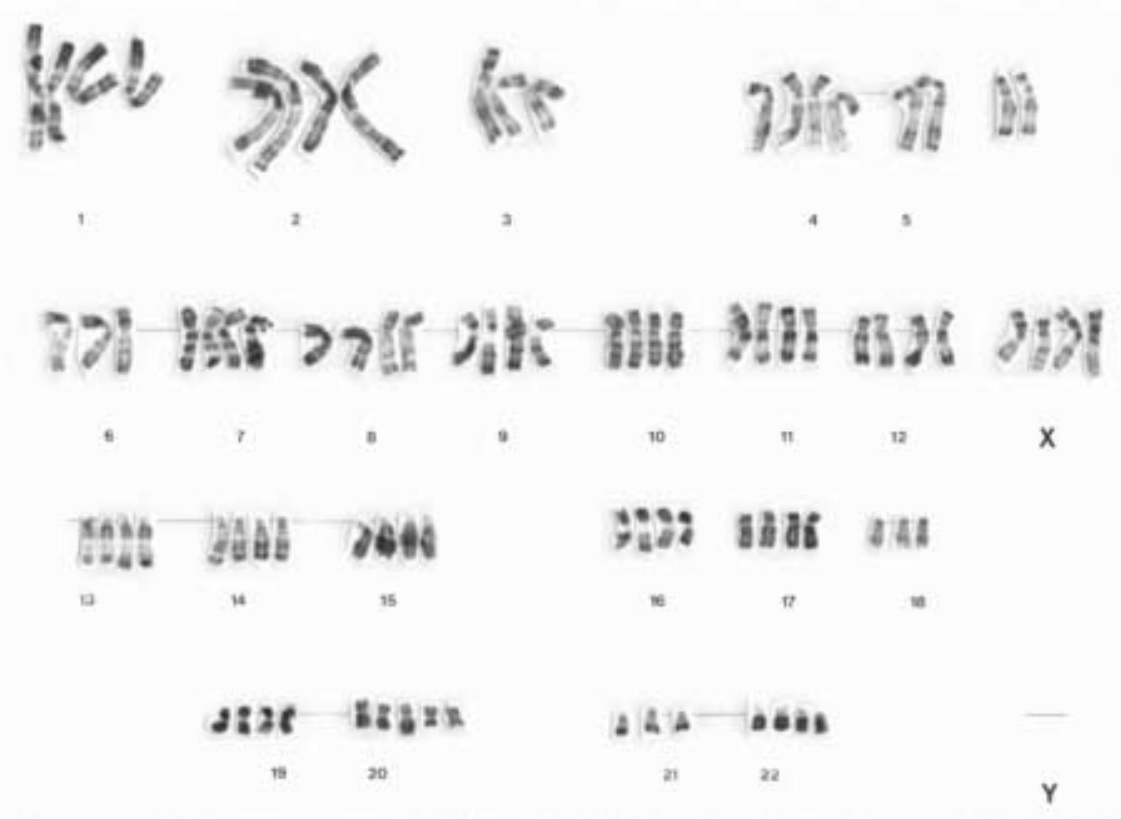
Fig. 1. R-banded karyotype of a representative near-tetraploid metaphase of Igrov1. The karyotype was interpreted as 85–92,XXX,der(X)t(X;18) (p11;p11),t(2;5)(q3?6;q2?3)x2,der(2)t(2;20)(q3?7;?), − 3,der(3)inv(3)(p13p25)del (3)(p14)x2, − 6,?der(7)(p22),der(9)t(9; 18)(q34; q2?2)x2, der(13)t(13;20)(q34;q12)x2, − 18, + 20, del(20)(q12)x2, −